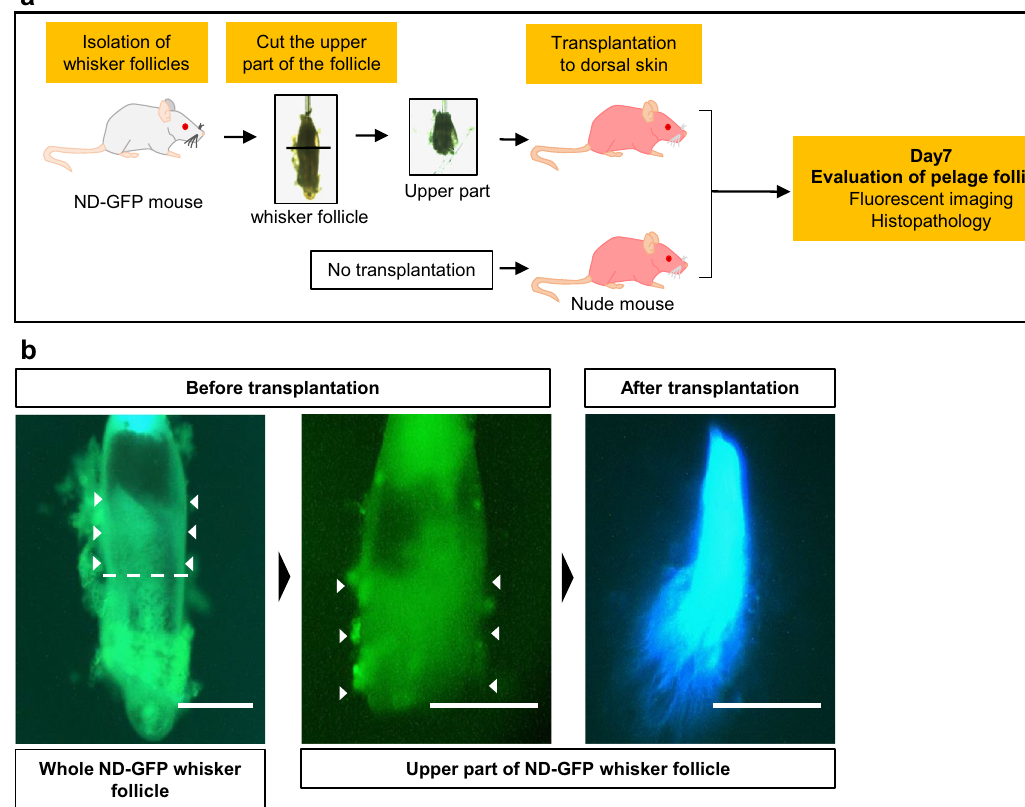
Figure 1. The upper part of whisker follicle from ND-GFP mouse before and after transplantation. ( a ) Schematic representation of experiment. ( b ) Whole-whisker follicle in ND-GFP mice and its upper part before and after transplantation to nude mice. White dotted line indicates cut part of the whole whisker follicle. White arrowheads indicate HAP stem cells in the bulge area. Scale bar = 500